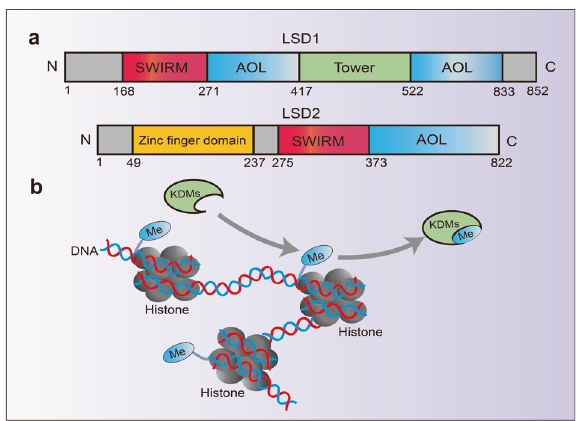
Fig. 6 Structure domain of LSD family and catalytic mechanism. a Structure domain difference between LSD1 and LSD2. b Structure of histone and the demethylase catalytic process, every two molecules of histone H2A, H2B, H3, and H4 constitute a core protein octamer, and then about 146 bp of DNA is bound around the octamer to form a nucleosome, demethylases can function by removing methyl groups from histones Signal Transduction and Targeted Therapy (2023)